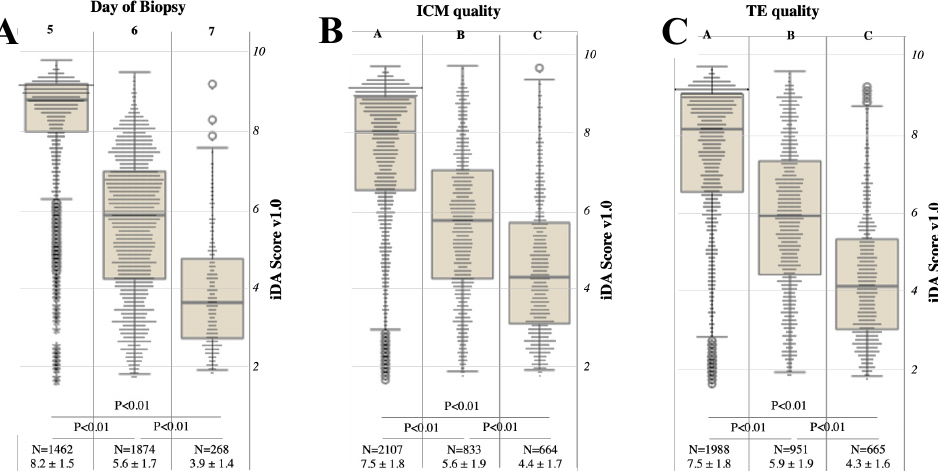
Figure 3. iDAScore v1.0 is associated with the day of biopsy ( A ), the inner cell mass (ICM) quality ( B ), and the trophectoderm (TE) quality ( C ). The day of biopsy is defined according to hours between insemination and achievement of a grade of blastocyst expansion compatible with a TE biopsy: ≤ 120 h post insemination (hpi) = day 5, 121–144 hpi = day 6, >144 hpi = day 7. ICM and TE quality were defined according to Gardner’s score as A, B, or C (from best to worst